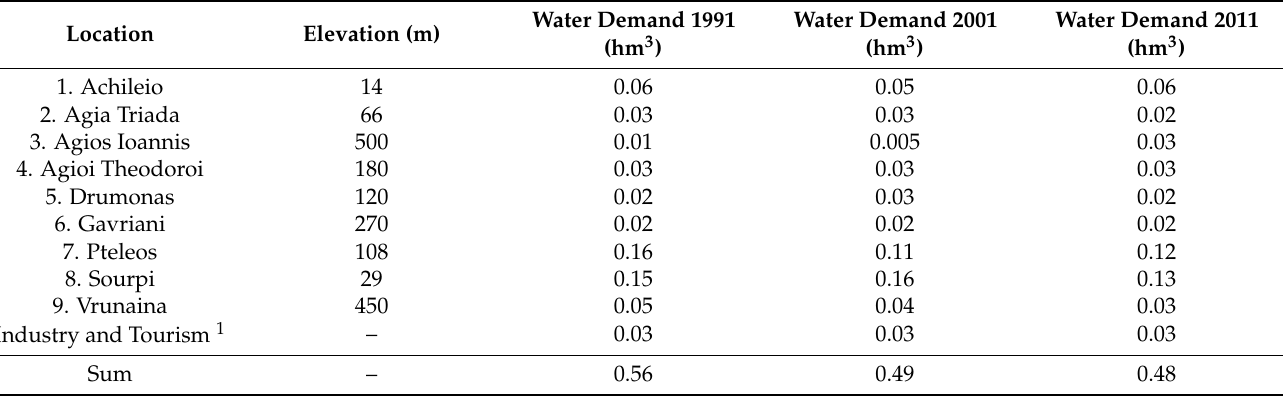
Table 2. Urban Demand Sites linked to Mavromati